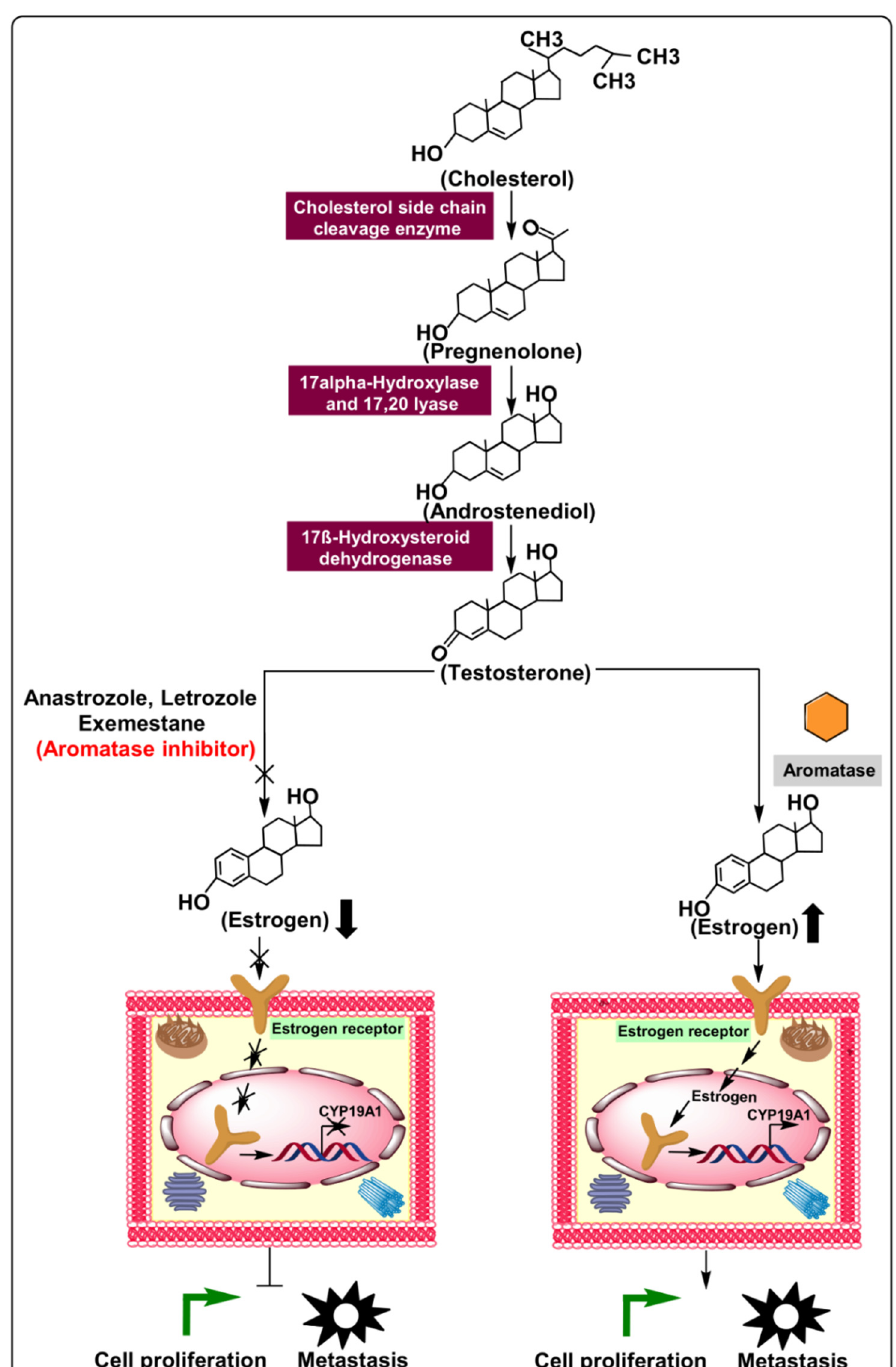
Figure 1. Biosynthesis of estrogen and mechanism of action of aromatase in cellular proliferation and metastasis via regulation of the estrogen production pathway. Additionally, aromatase inhibitors’ relative preferences over typical ER-positive cancerous cells demonstrate enhanced cellular proliferation and metastasis.